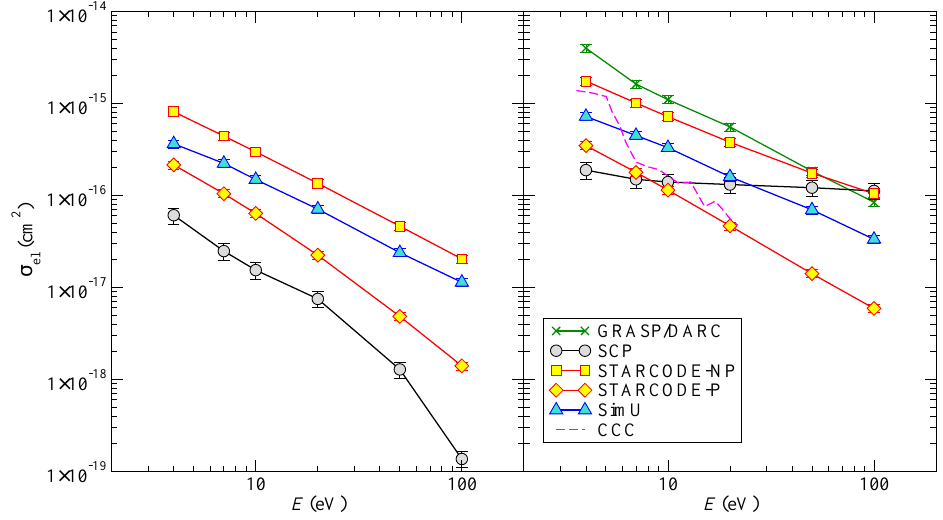
Figure 13. B III 2 s − 2 p elastic pseudo cross-section as a function of the energy E . ( Left ) only the dipole interaction is taken into account; ( Right ) the dipole and quadrupole interaction are both taken into